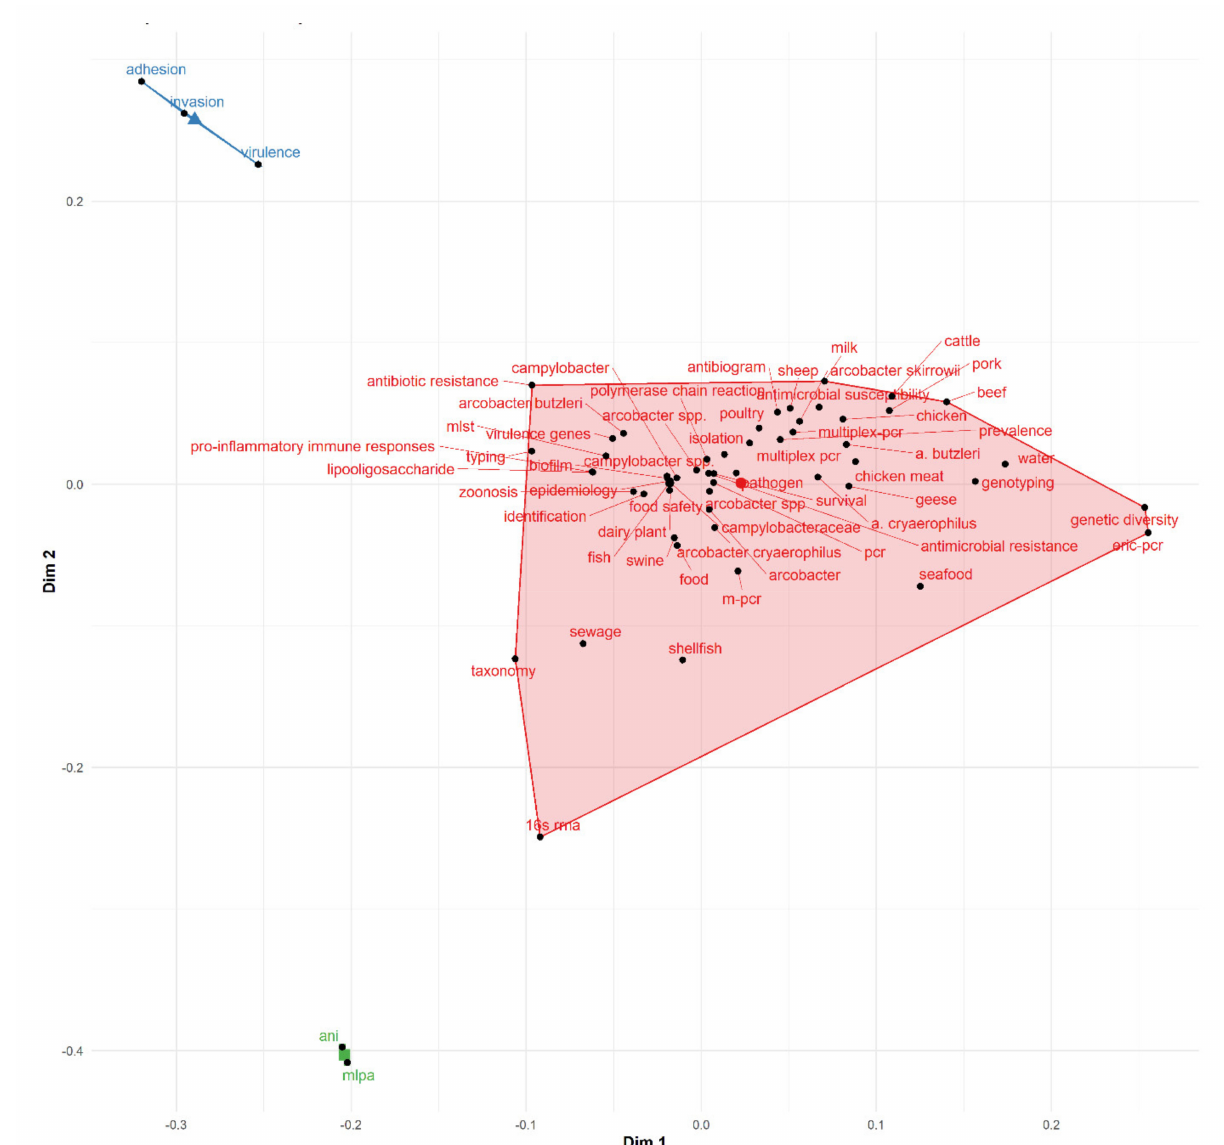
Figure 8. Conceptual frameworks in Arcobacter research. Dim 1 = Dimension 1; Dim 2 = Dimension